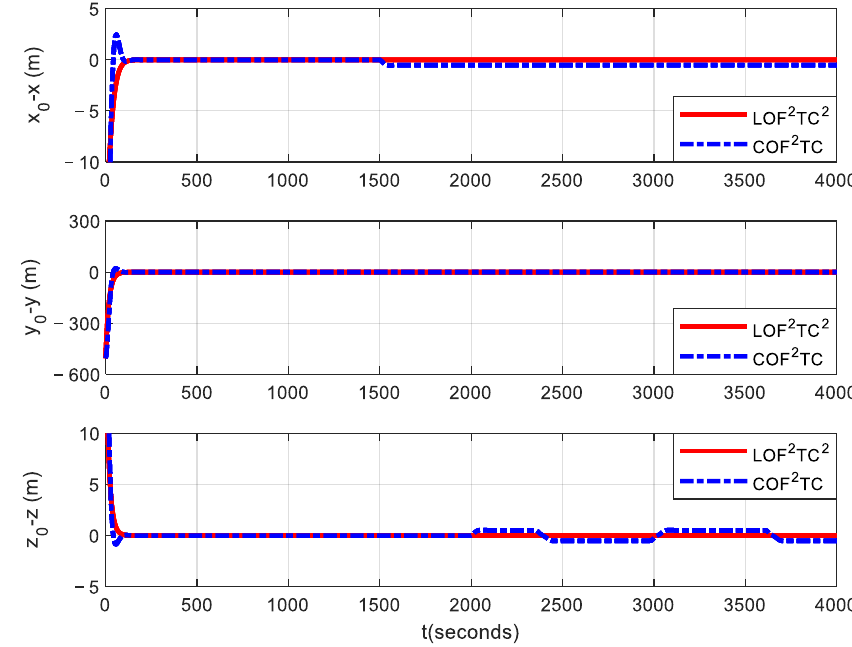
Figure 7. Relative position tracking error for formation maintenance.